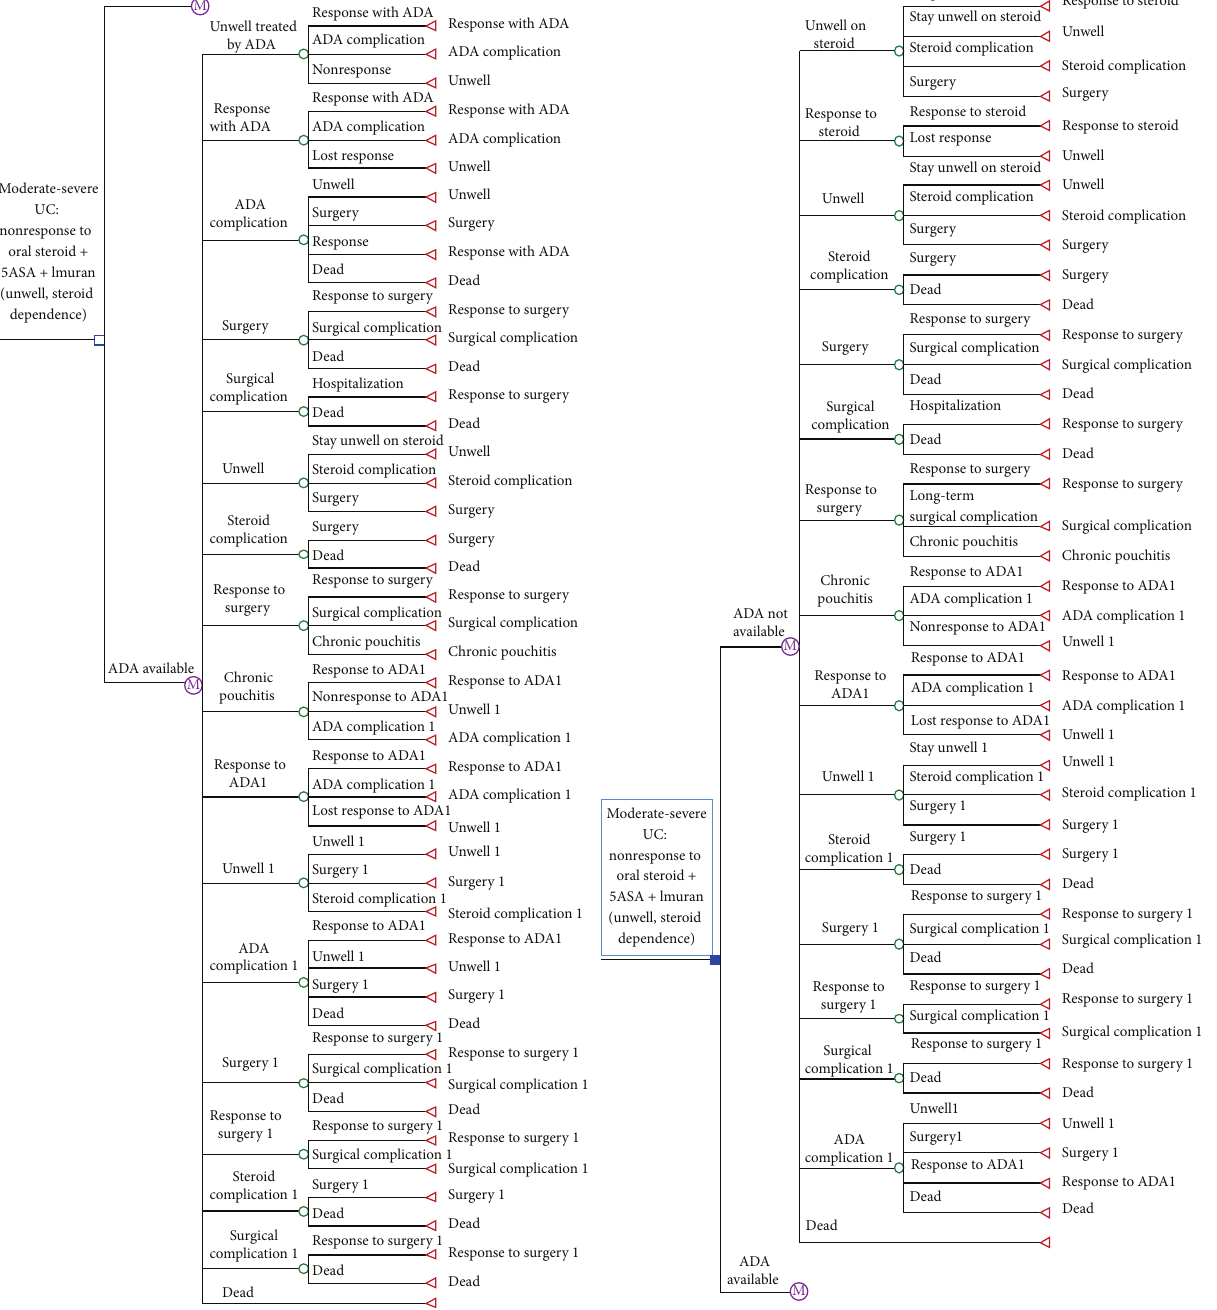
Figure 1: Markov model simulating the progression of a cohort of patients with moderate-to-severe ulcerative colitis, who are corticosteroid- dependent or refractory to thiopurines, in situations where adalimumab is readily available compared to situations when it is unavailable.